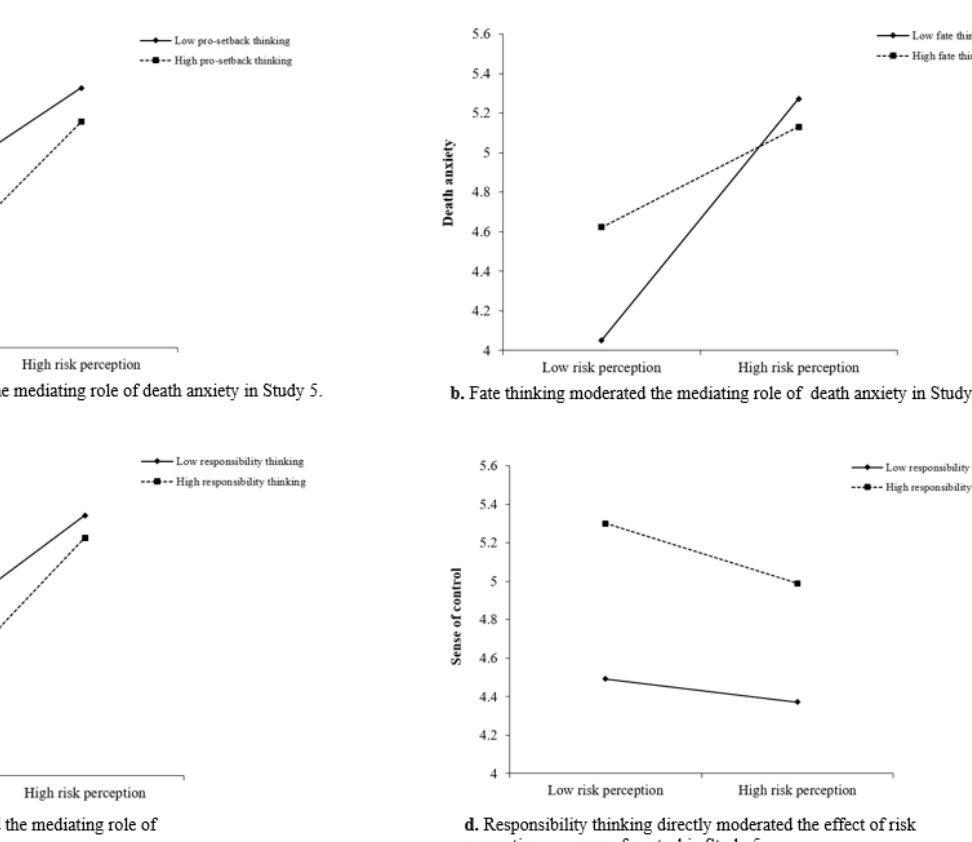
Figure 6. Confucian coping moderated the effect of risk perception on sense of control and the me- diating role of death anxiety in Study